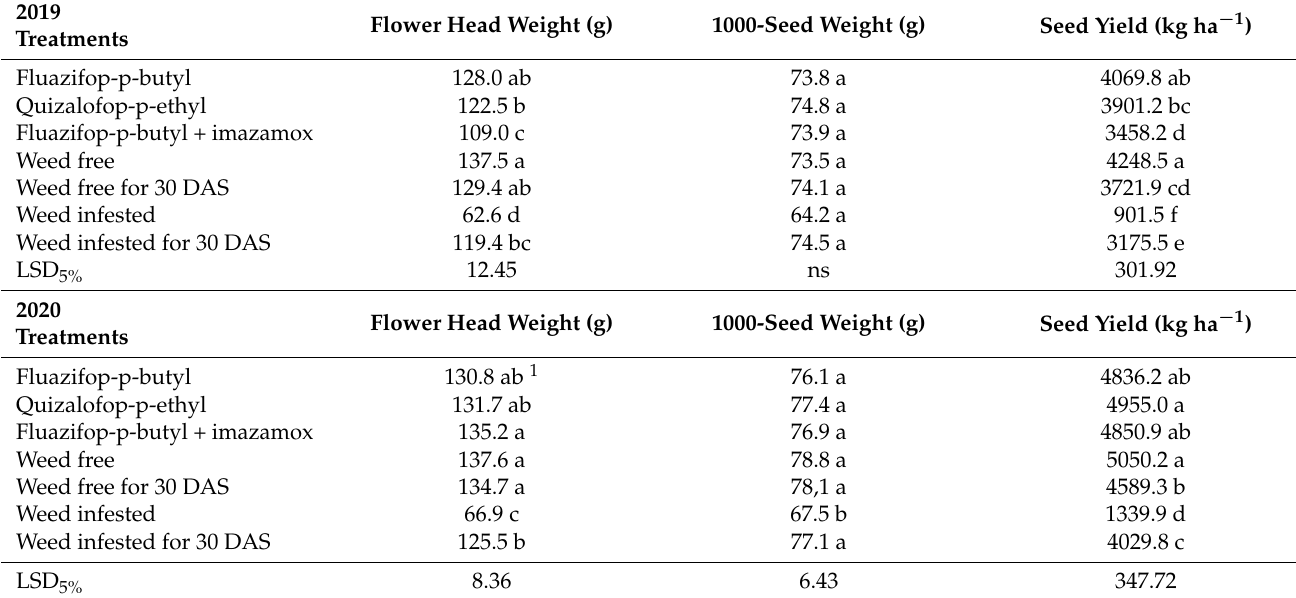
Table 1. Effects of various control treatments of Johnsongrass on sunflower flower head weight